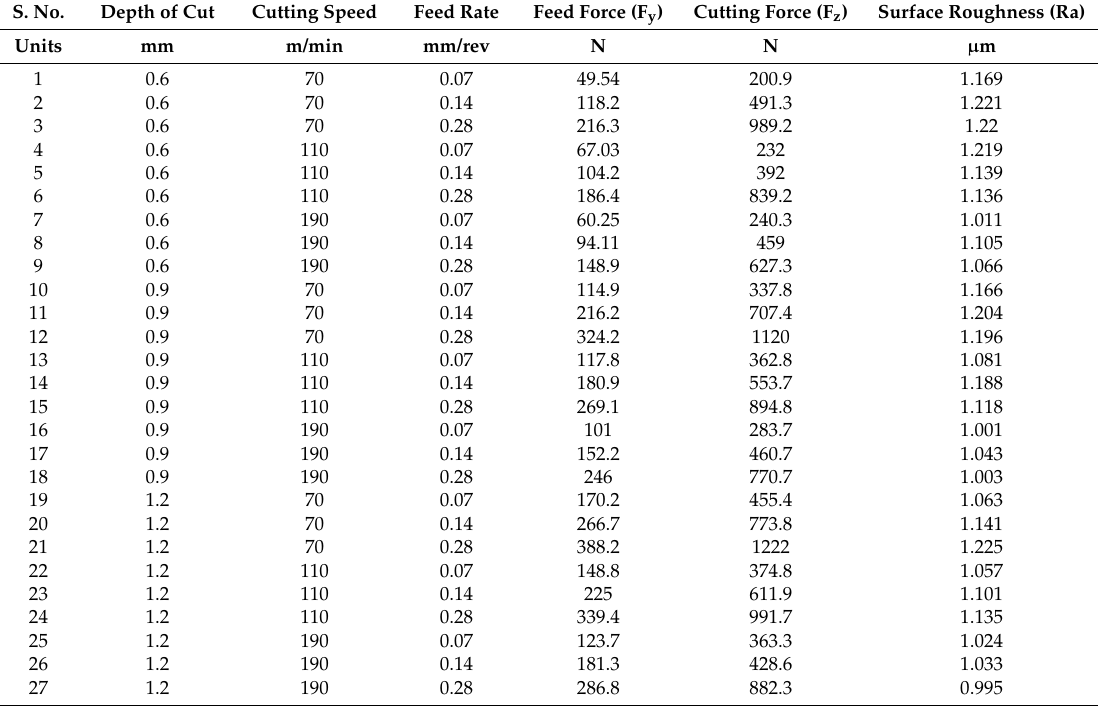
Table 2. Results of full factorial machining experiments.